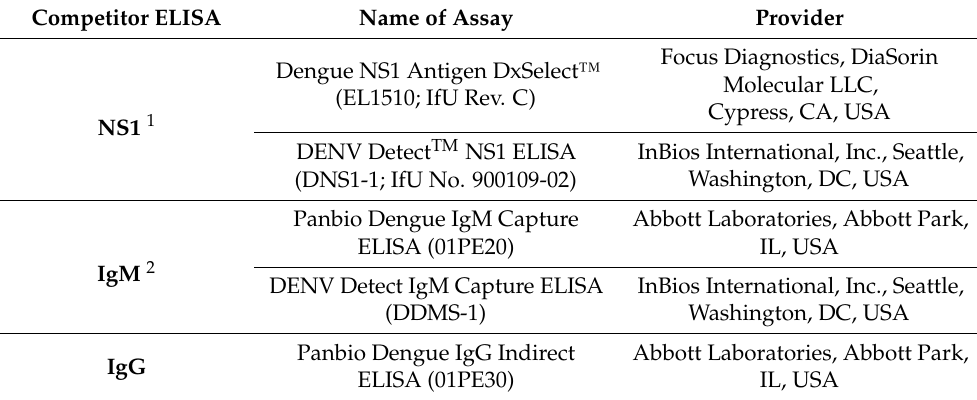
Table 2. Competitor ELISA used for the concordance analysis with the VIDAS ® Dengue assays.